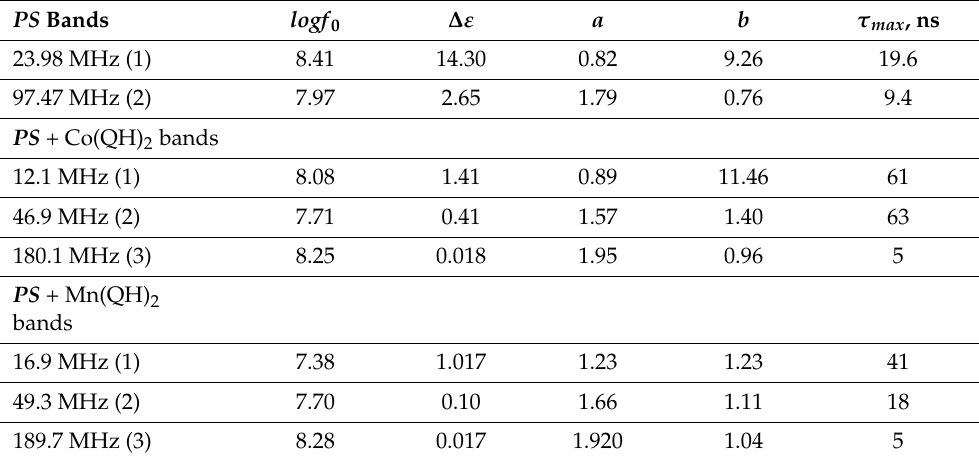
Table 2. Values of the coefficients logf 0 , ∆ ε , a and b for the Havriliak–Negami model, which allow for the construction of curves of the distribution of relaxation times g( τ ) for bands with numbers given in parentheses and correspond to the numbers in Figure 8 (From [48] with